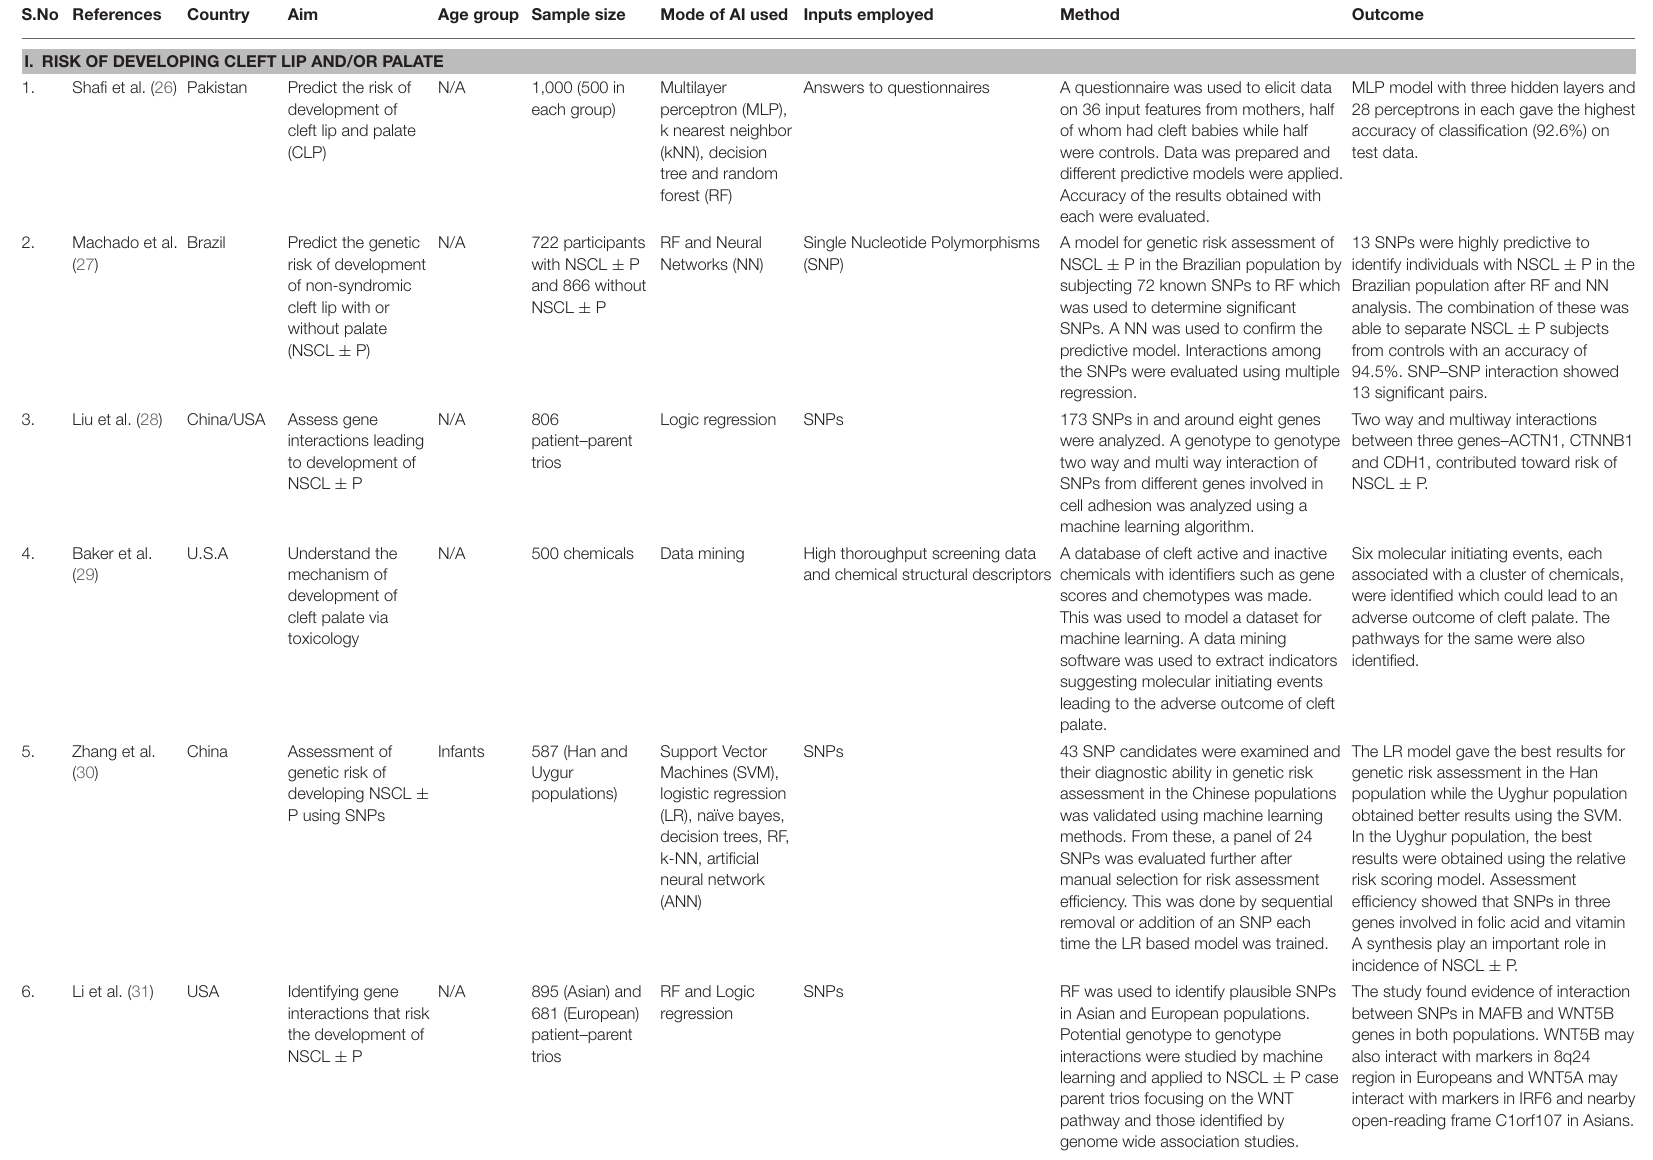
TABLE 1 | Characteristics of Included